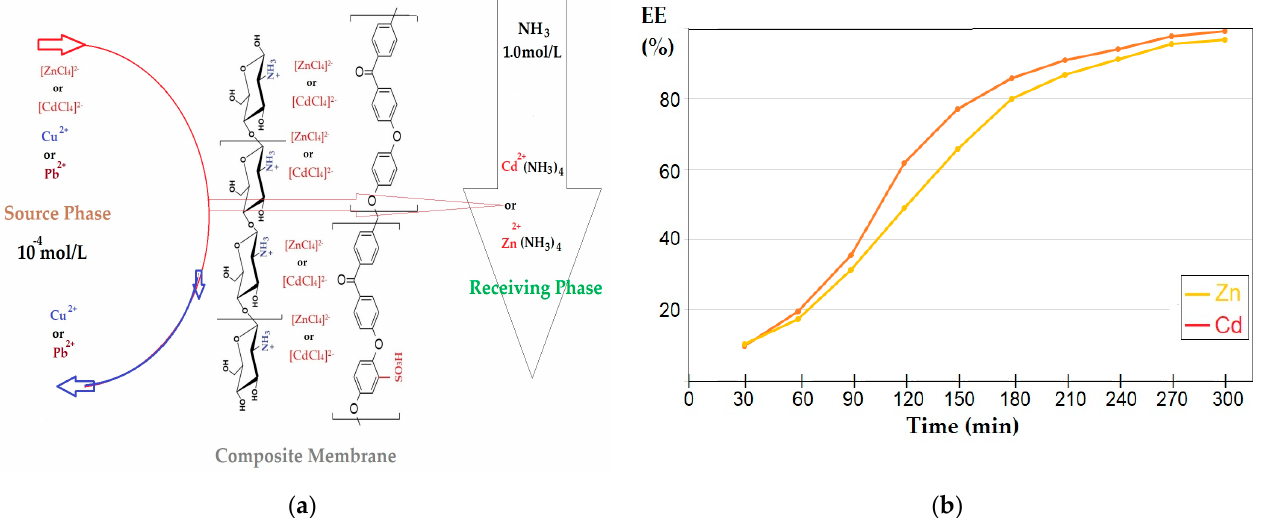
Figure 14. Separation of the mixture of equimolar concentration of 10 − 4 mol/L of the copper and zinc ions, or lead and cadmium ions, from the strongly acidic source phase (3 mol/L hydrochloric acid) by pertraction in the ammonia-receiving phase (NH 3 aqueous solution 1.0 mol/L): ( a ) trans-membrane transport scheme; ( b ) the efficiency of cadmium or zinc ion extraction.